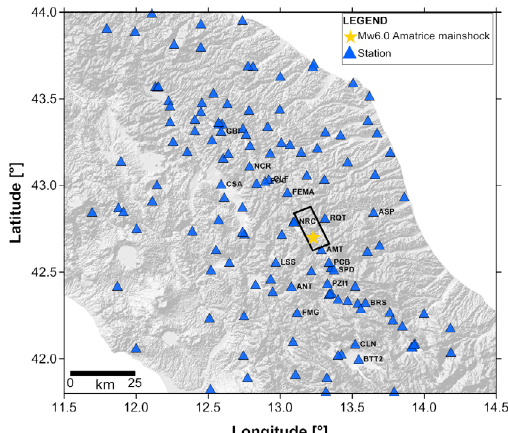
Figure 1 . Location of the epicenter (yellow star) of the Amatrice (M 6.0) earthquake and distribution w of the recording stations (blue triangles). The sur- face projection of the causative fault by Tinti et al. (2016) is also shown.